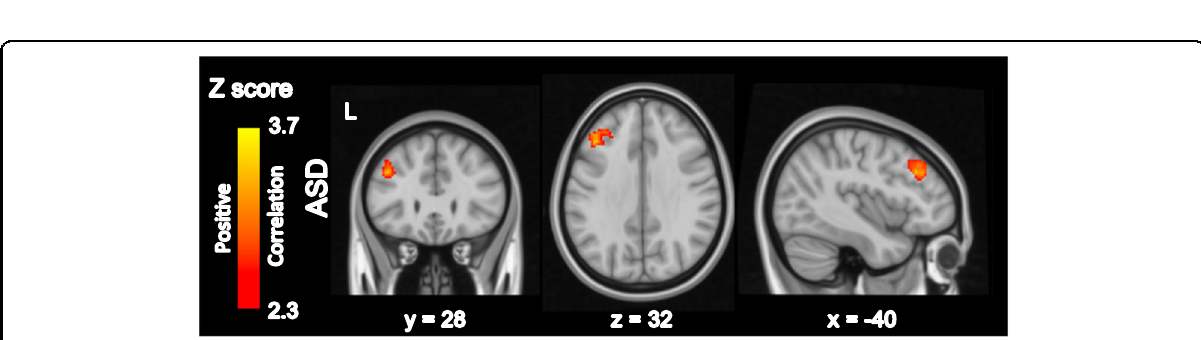
Fig. 3 Somatosensory Cortex Connectivity Related to SSC Glx/Cr. Whole-brain resting-state analysis using bilateral precentral gyrus seed with Glx/Cr as a bottom-up regressor. Within-group and between-group contrasts were thresholded at Z > 2.30 and cluster corrected at p < 0.05 (see eFig. 3.B for unthresholded maps), only within ASD demonstrated a signi fi cant relationship with Glu/Cr. ASD Autism spectrum disorders, L